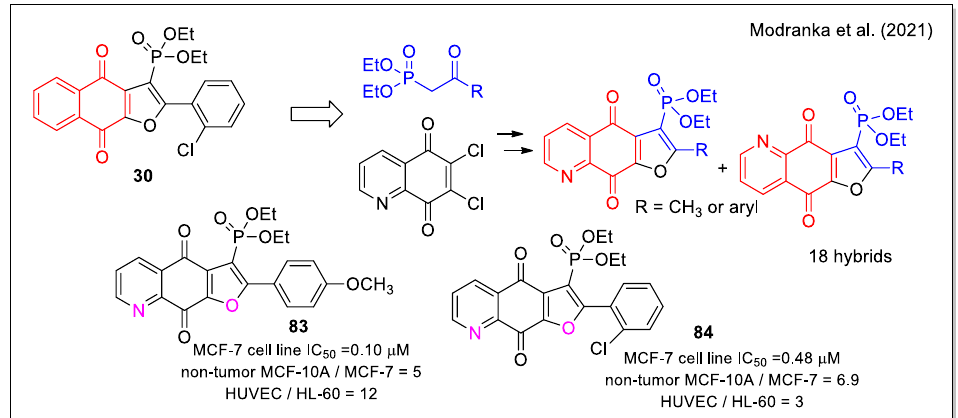
Figure 30. Quinolinedionefurandione – phosphonate hybrids as reported by Modranka et al. [71].